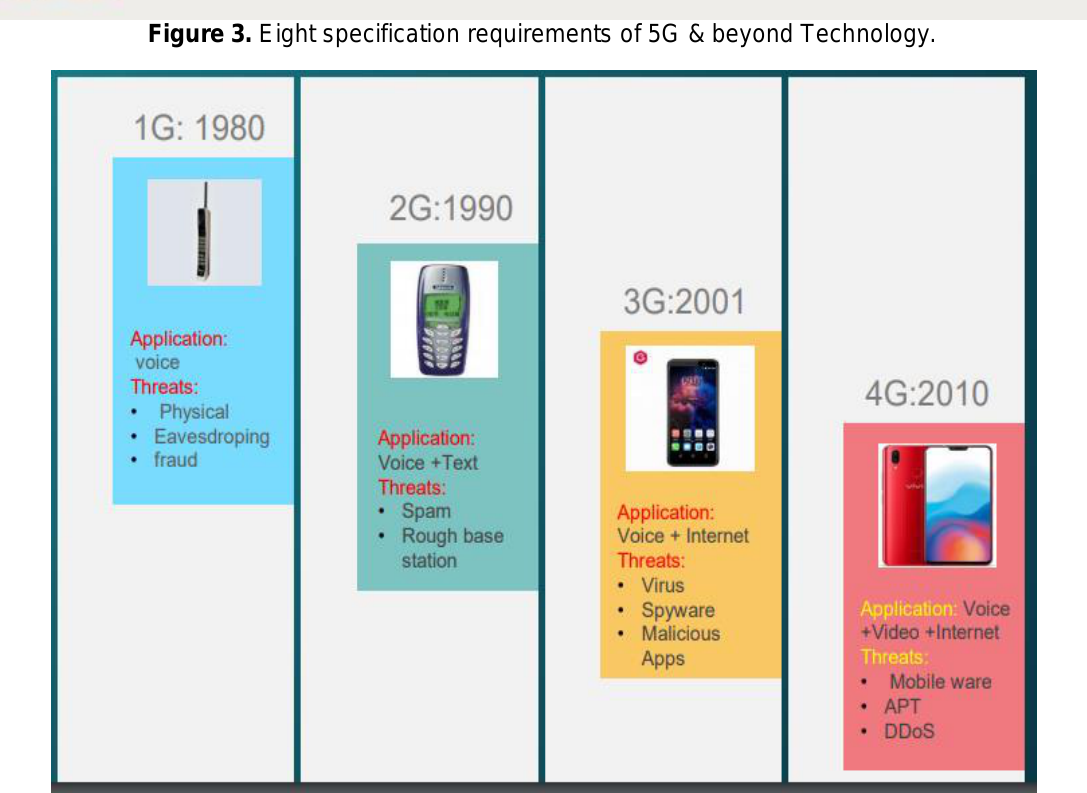
Figure 3. Mobile network security growth and threat